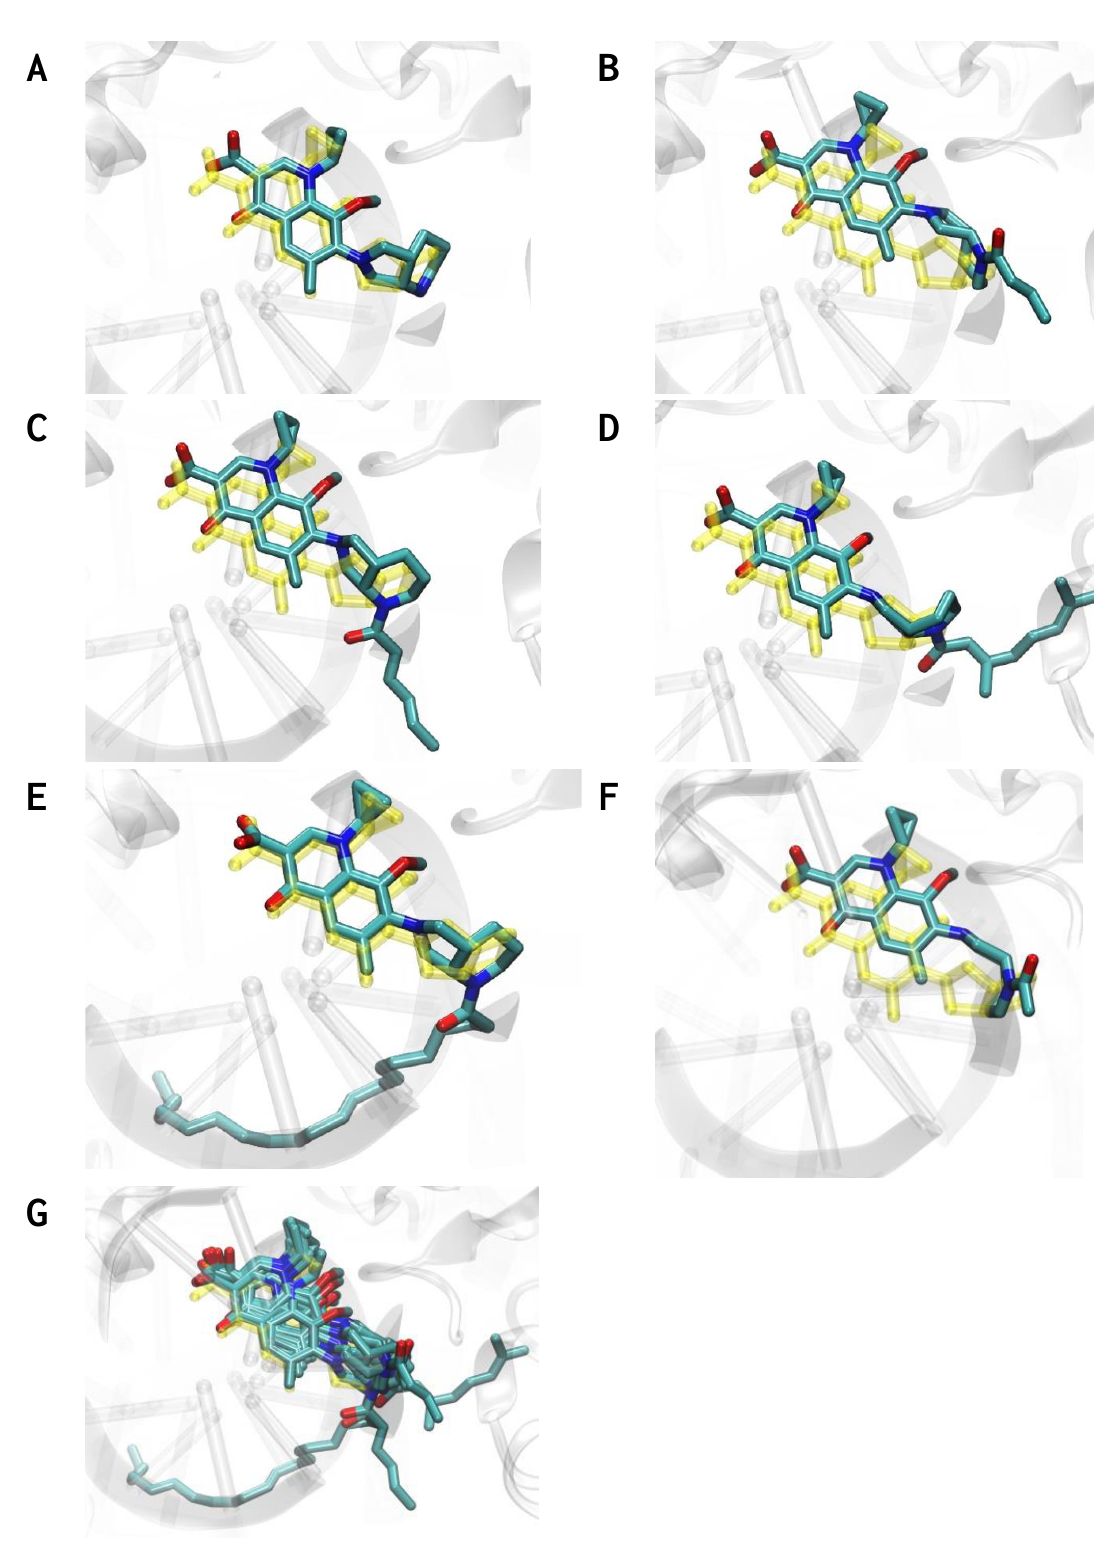
Figure 6. Binding modes of docked ligands to DNA gyrase structure (PDB ID: 5BS8 [34]). Structure of bound MXF and its five derivatives: 1m – 3m , 8m , and 14m panels ( A – F ). Superimposition of six docked ligands is shown in panel ( G ). For comparison, the structure of MXF present in the crystal structure 5BS8 is shown in color yellow.